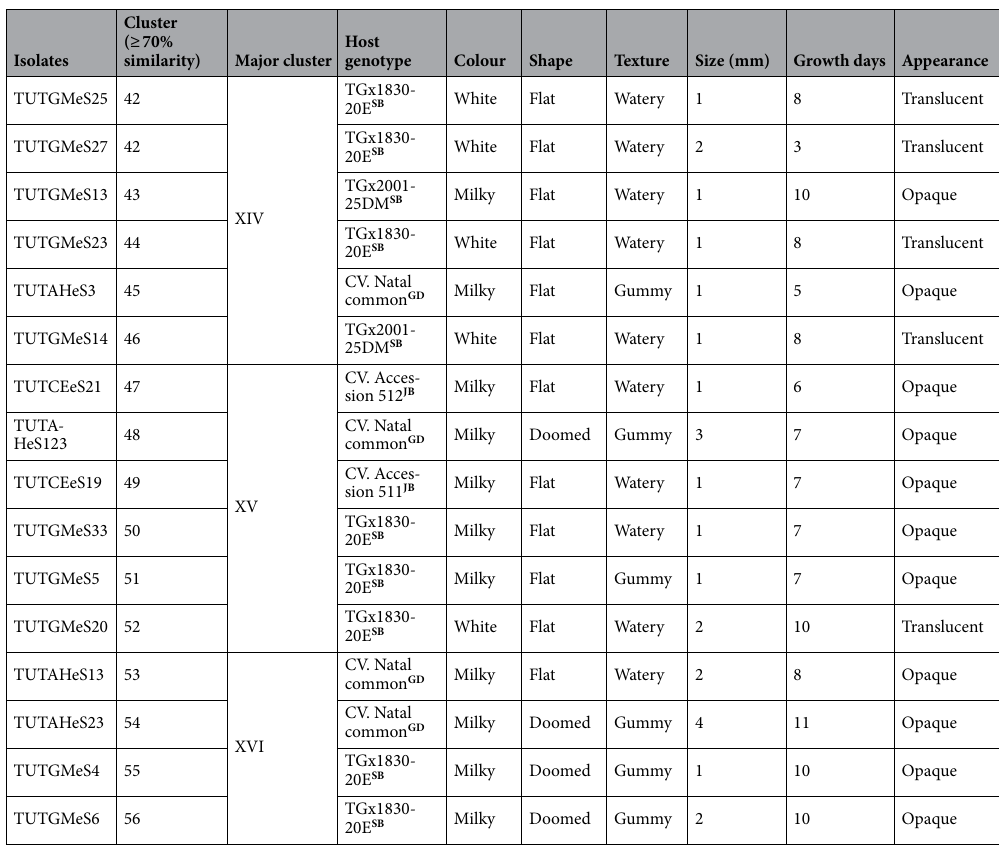
Table 1. Host genotype and morphological characteristics (colour, shape, texture, size, growth, and appearance) of groundnut, jack bean and soybean isolates used in this study. Growth refers to the number of days taken for colonies to appear on yeast mannitol agar plates while size represents colony dimeter. Species of host genotype are defined by superscripts as; groundnut ( Arachis hypogea ) = GD ; jack bean ( Canavalia ensiformis ) = JB and soybean ( Glycine max ) = SB